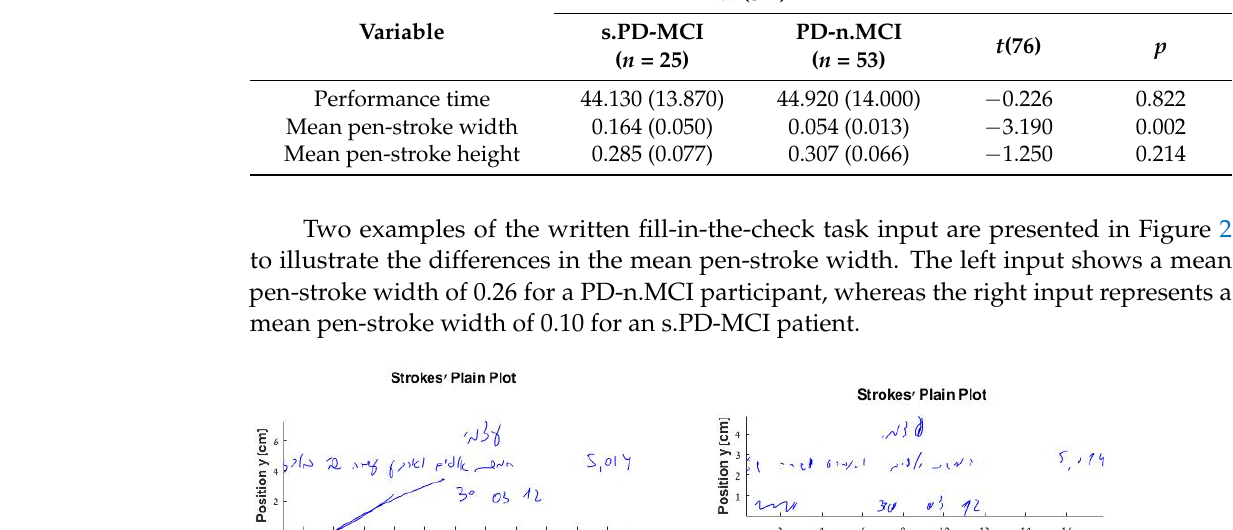
Figure 2. Examples of written fill-in-a-check task input by PD-n.MCI patient ( left ) and s.PD-MCI patient ( right ).